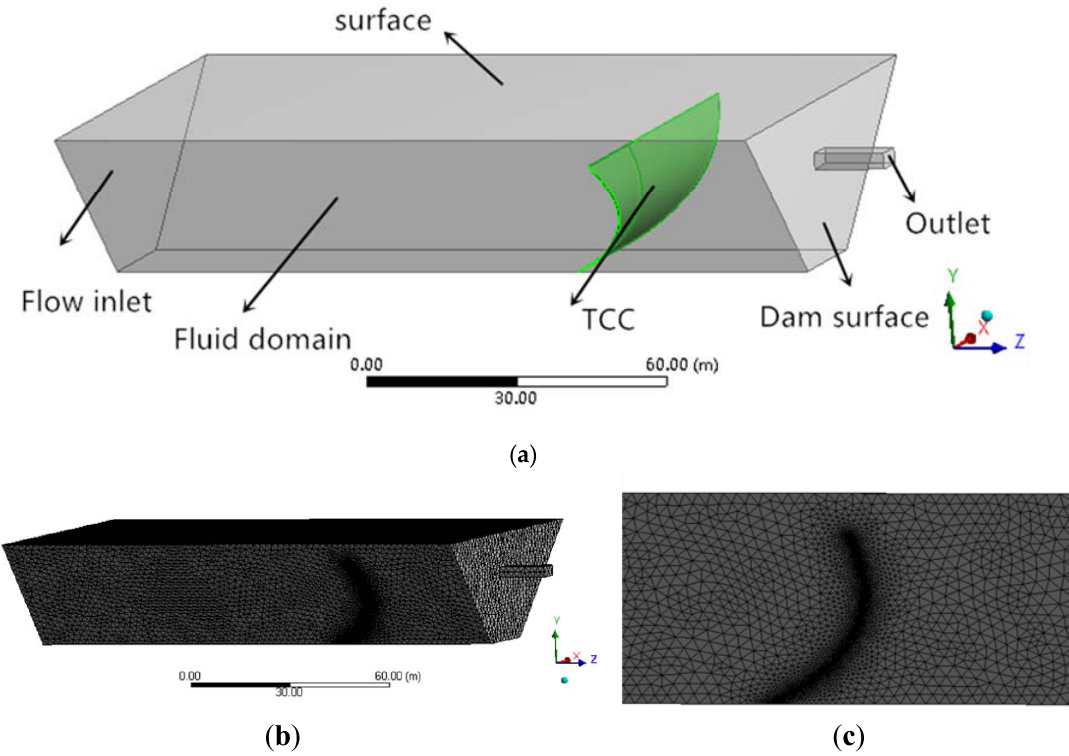
Figure 4. Schematic and meshes of the numerical simulation model: ( a ) computational domain of simulation model; ( b ) global mesh; ( c ) encrypted grid near TCC (model size: length 165 m, top width 78 m, bottom width 20 m, water depth 32.5